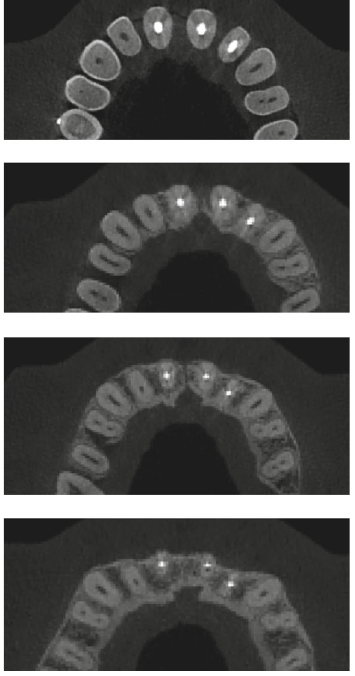
Figure 9: CBCT images — 3 years after